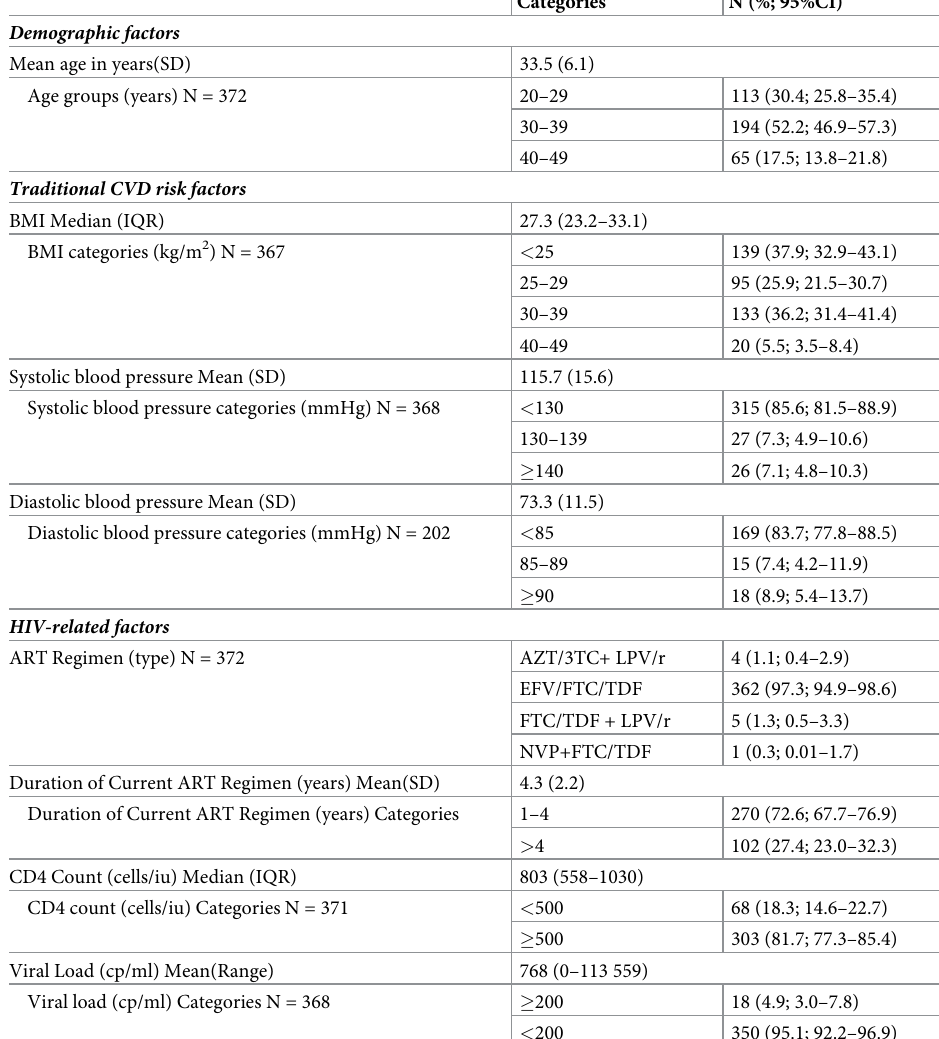
Table 1. Prevalence of CVD risk factors determined as per standard of care in total study population (N =